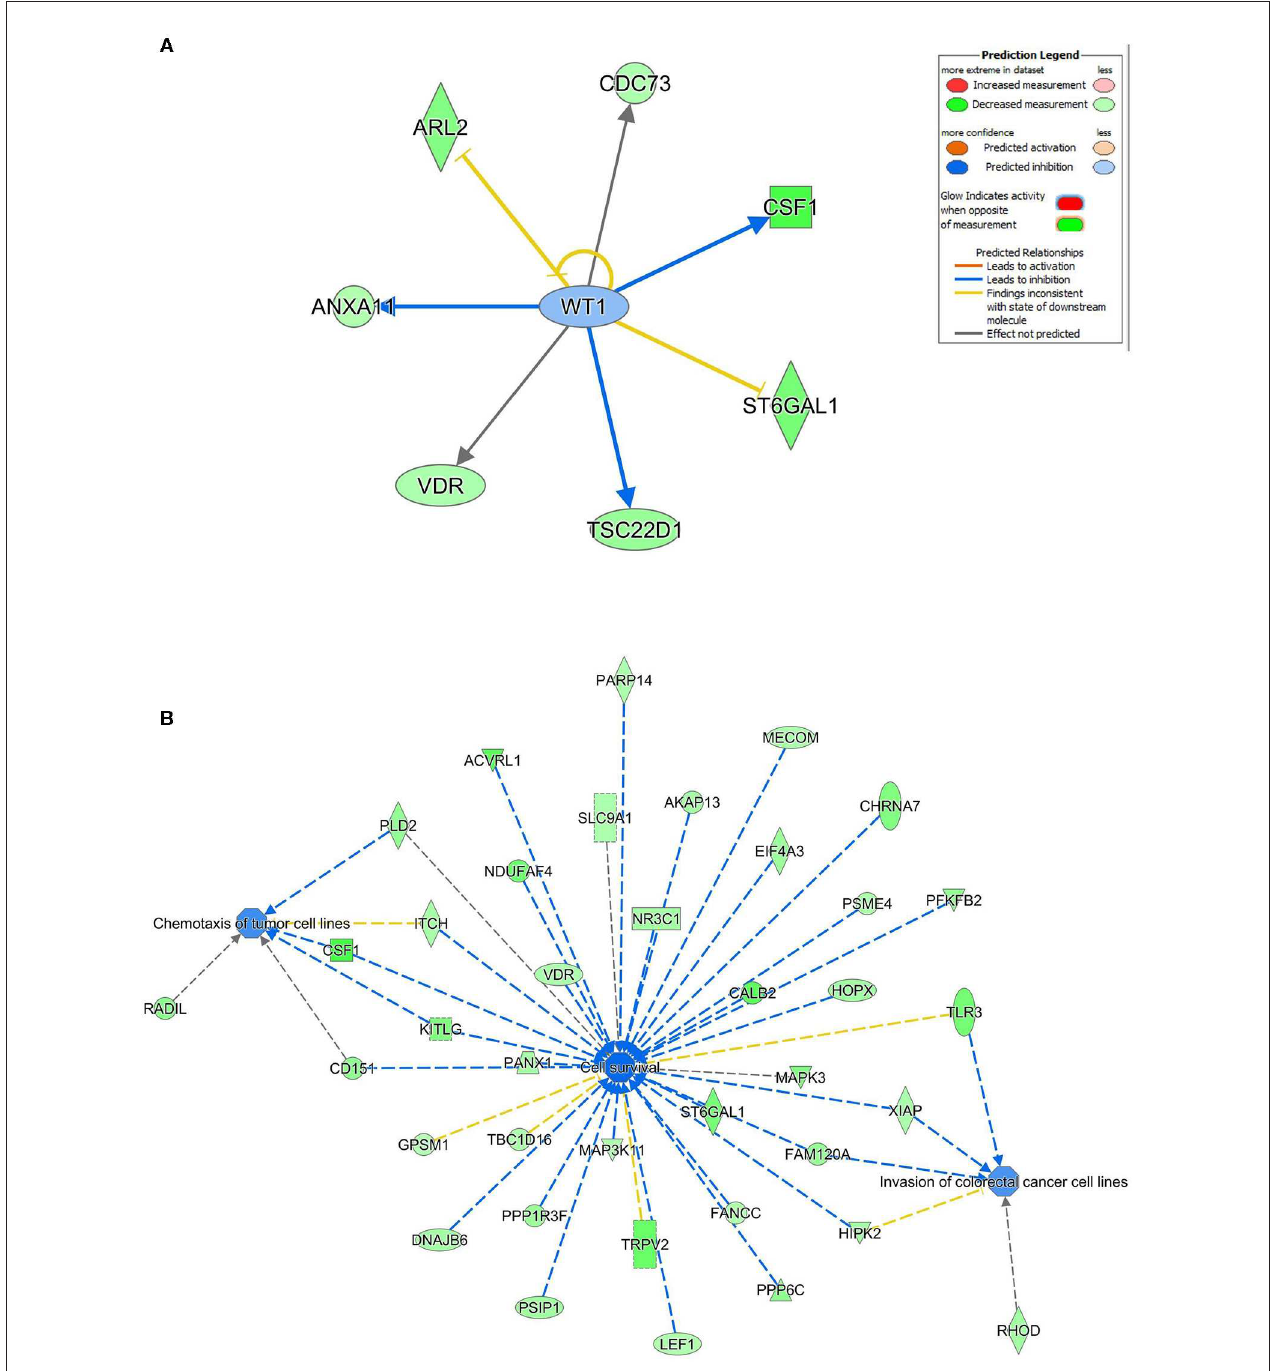
FIGURE 6 | Regulated of the WT1 network, cell survival, invasion, and chemotaxis by hsa-miR-214. (A) Illustration of the WT1 mechanistic network based on the identified hsa-miR-214-3p gene targets and IPA analysis. (B) Functional networks illustrating the involvement of the indicated hsa-miR-214-3p gene targets in regulating cell proliferation, cell spreading, and organization of cytoskeleton based on IPA